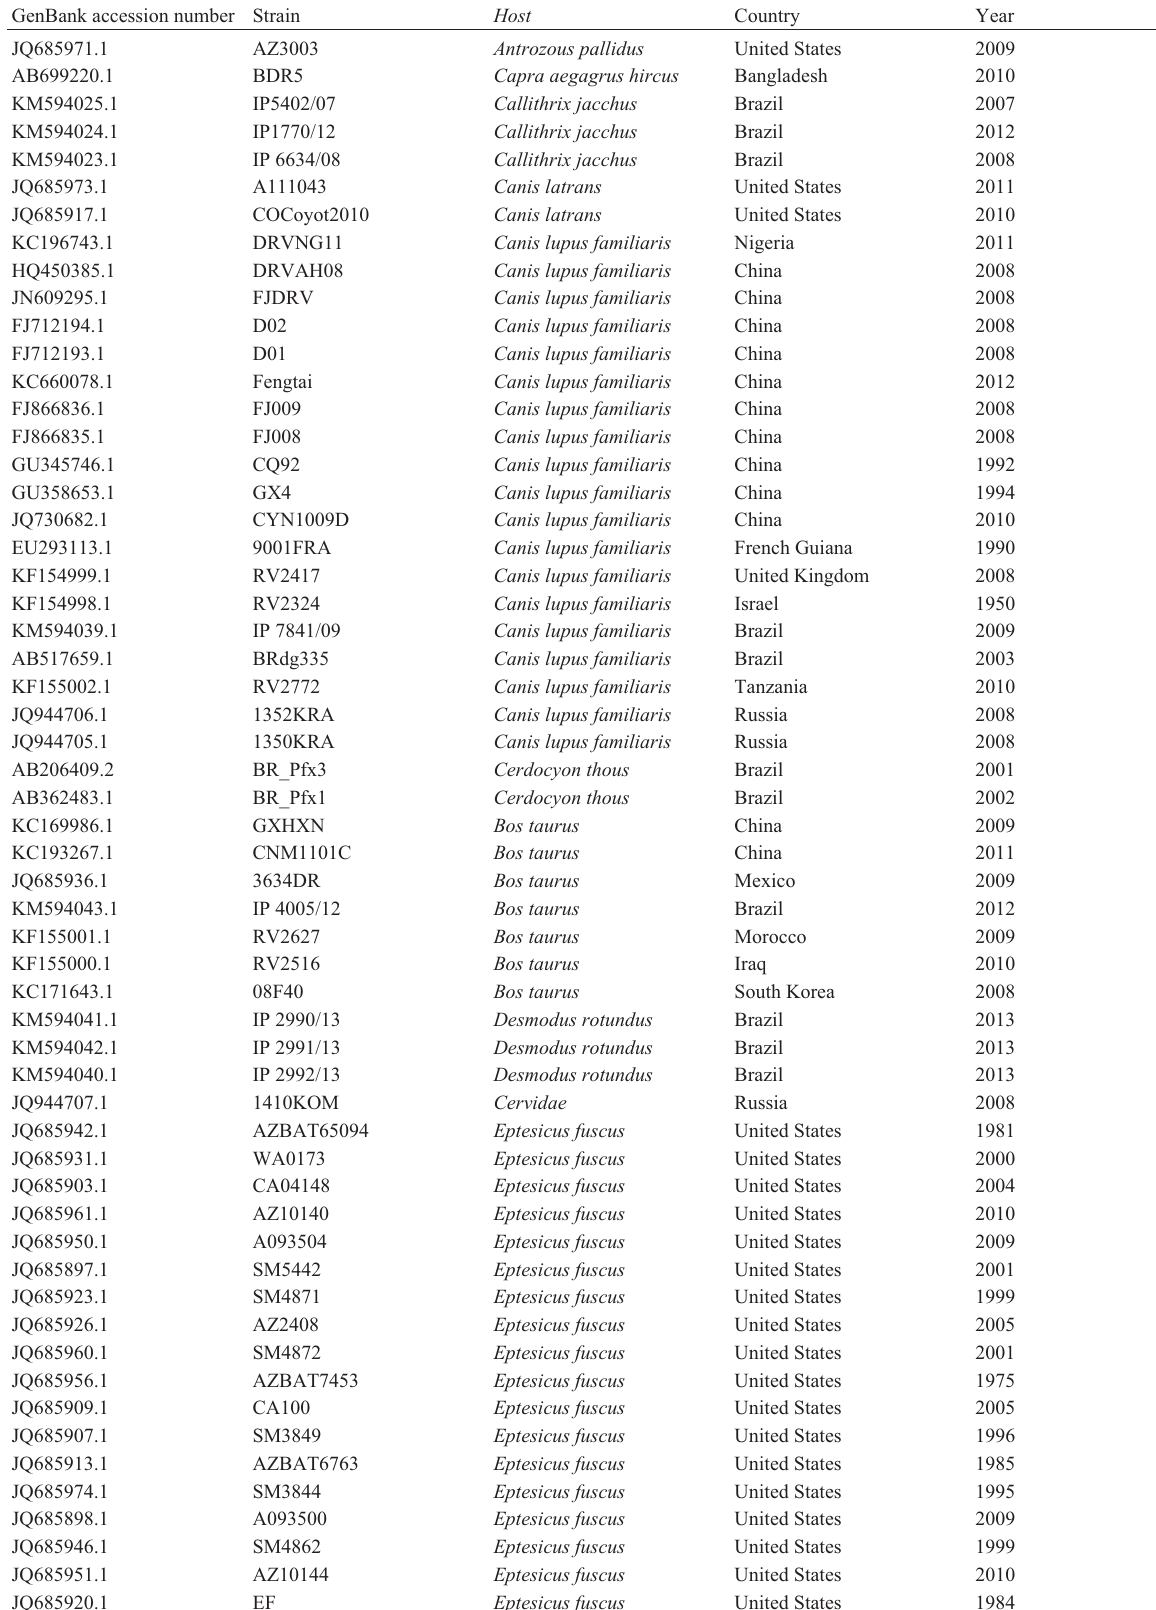
Table 2 - Strains used in the study: accession number, reference, host, country and year of isolation. GenBank accession number